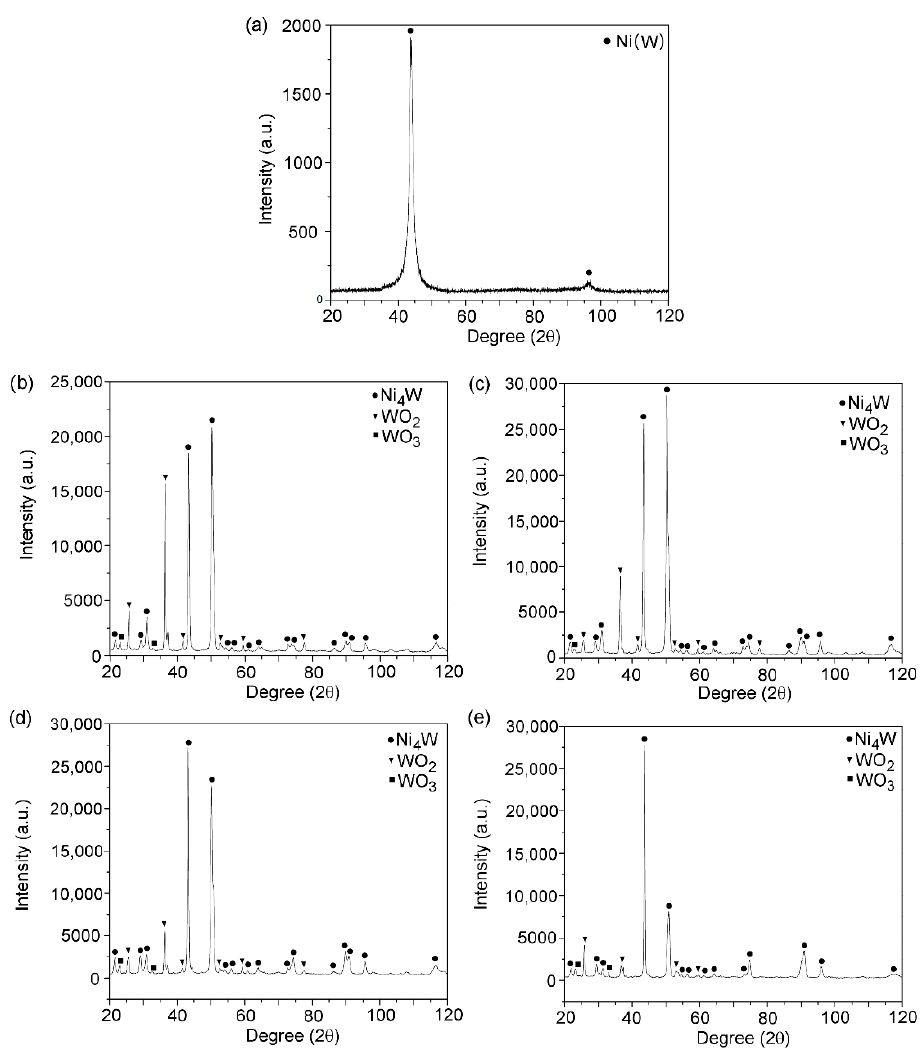
Figure 2. X-ray di ff raction patterns for the as-deposited ( a ) C175 / - and after heat treatment ( b ) C125 / 1173, Figure 2. X-ray diffraction patterns for the as-deposited ( a ) C175/- and after heat treatment ( b ) ( c ) C150 / 1173, ( d ) C175 / 1173, ( e ) C200 / 1173 Ni-W C125/1173, ( c ) C150/1173, ( d ) C175/1173, ( e ) C200/1173 Ni-W coatings.